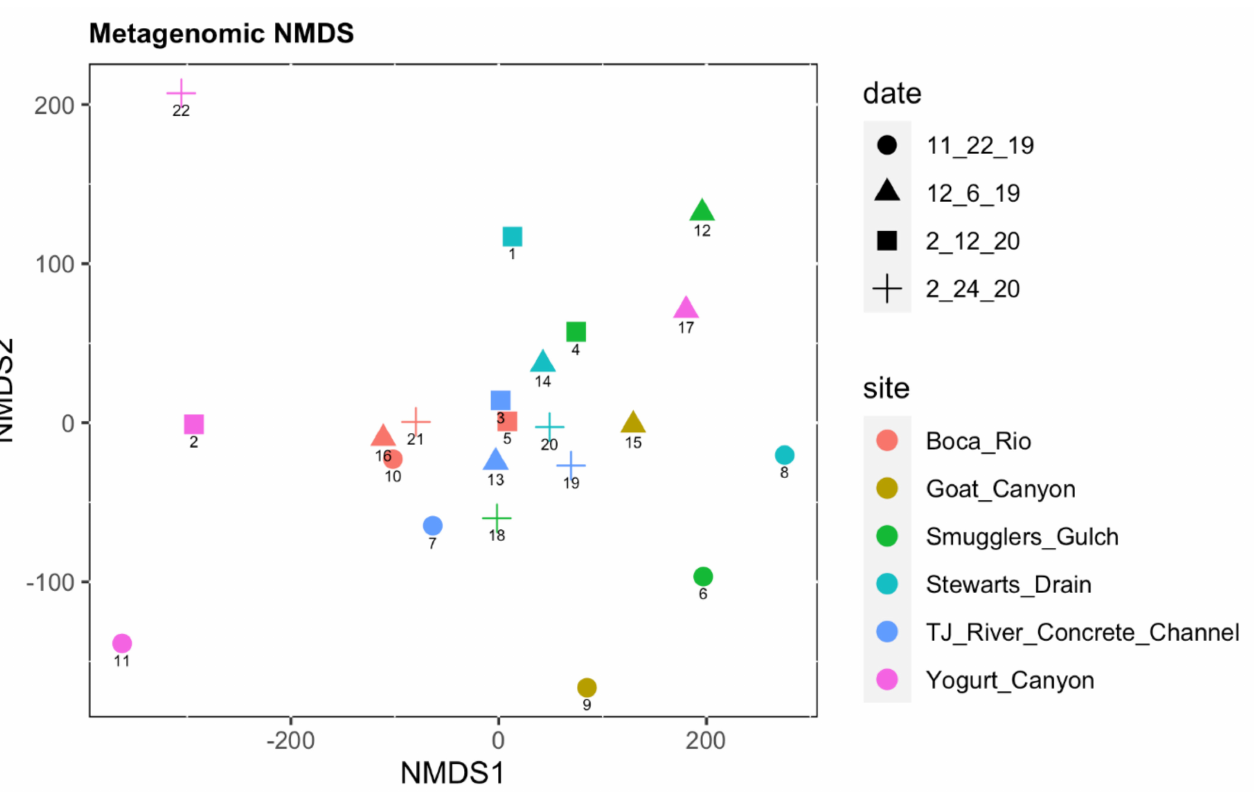
Figure 2. Metagenomic Non-Metric Multidimensional Scaling